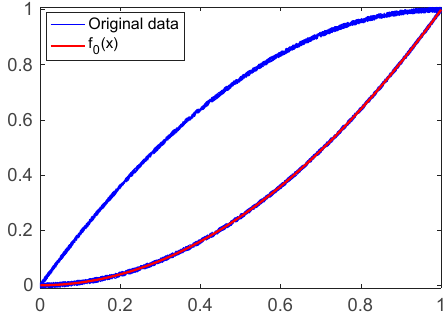
Figure 6. Simulation data and the function f 0 ( x ) in Example 1.